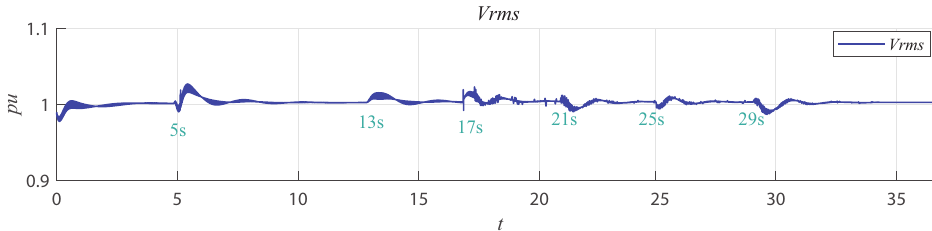
Figure 27. RMS voltage in per unit for case study